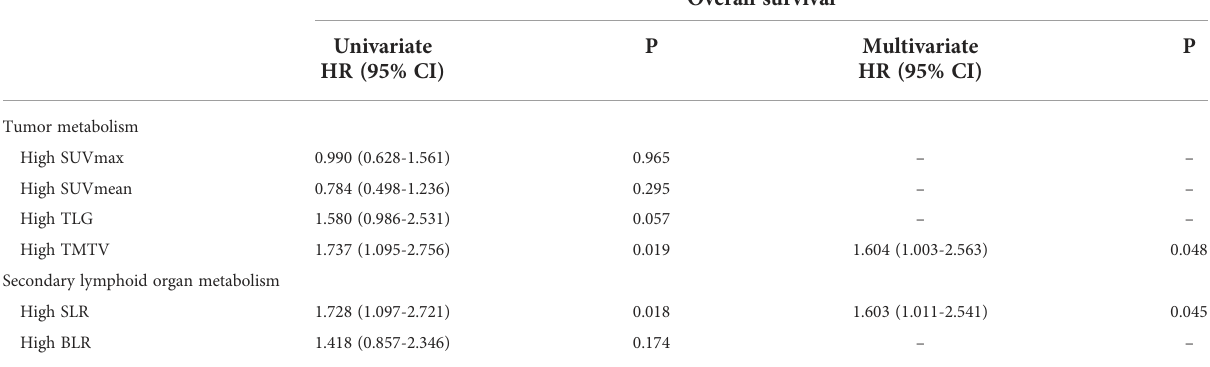
TABLE 3 Prognostic signi fi cance of PET biomarkers for overall survival in univariate and multivariate